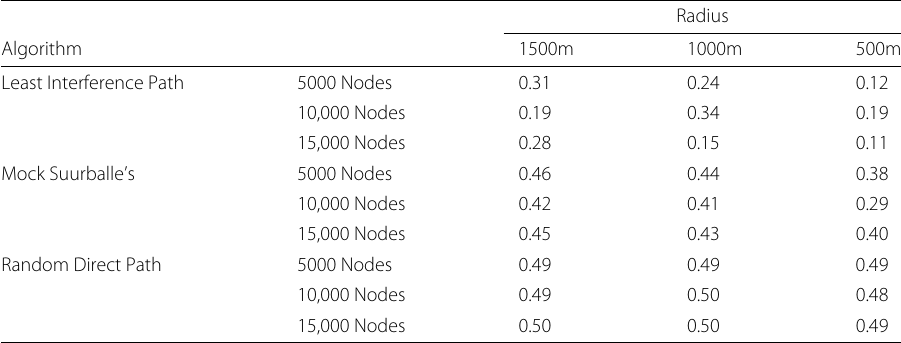
Table 1 Results of three